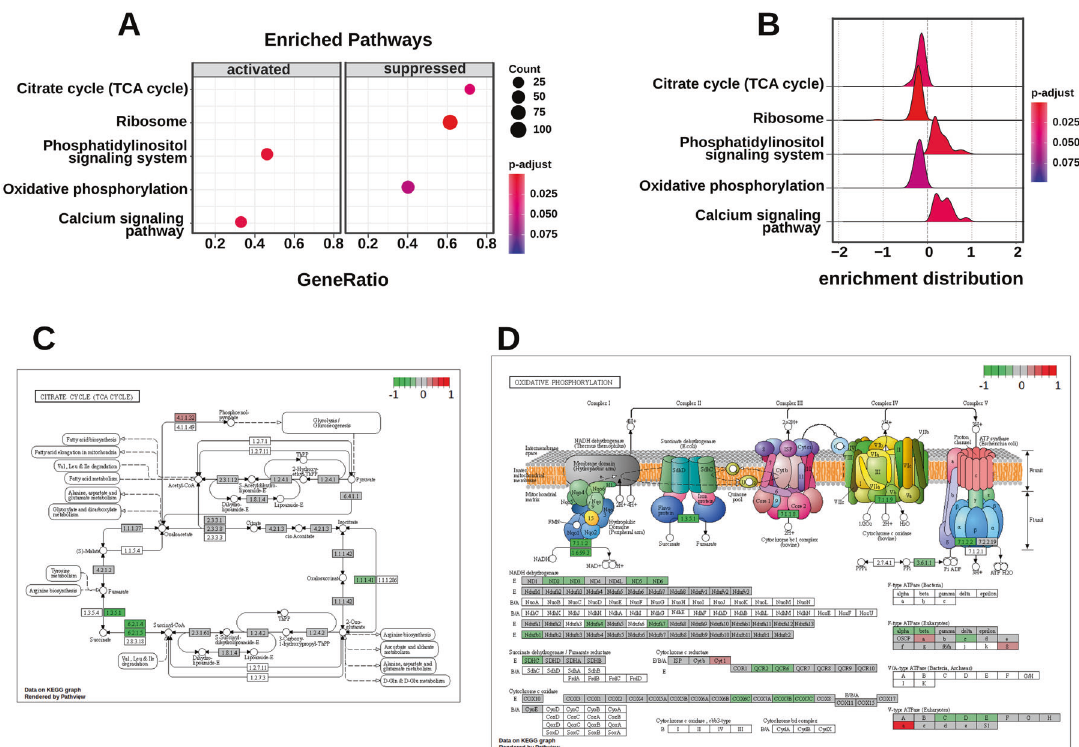
Fig. 6 Overview of the results of the GSEA analysis. A Enrichment plot displaying activated and suppressed pathways including the count of annotated genes, the adjusted p -value, and the ratio of activated or suppressed genes. B Rigde plot displaying the enrichment distribution of the pathways over the log2 foldchange. C Overview of the normalized downregulation (green) and upregulation (red) of the genes of the TCA cycle. D Overview of the normalized downregulation (green) and upregulation (red) of the genes of oxidative